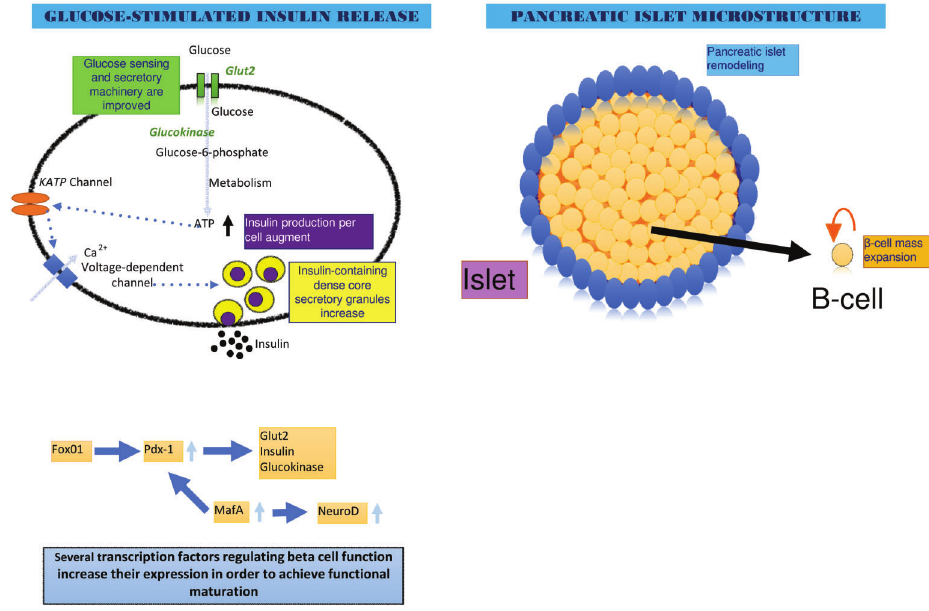
Figure 2. Functional and morphological postnatal pancreatic maturation. After weaning, normal b -cell development culminates in two crucial maturation events: the left panel shows glucose sensing machinery is enhanced when insulin production per cell changes, leading to increases in insulin-containing dense core secretory granules. This results in the maturation of stimulus-secretion coupling. The right panel illustrates the establishment of appropriate b -cell mass in proportion to an individual ’ s body weight and pancreatic islet remodeling, leading to morphological maturation. Overexpression of key genes involved in the maturation process is